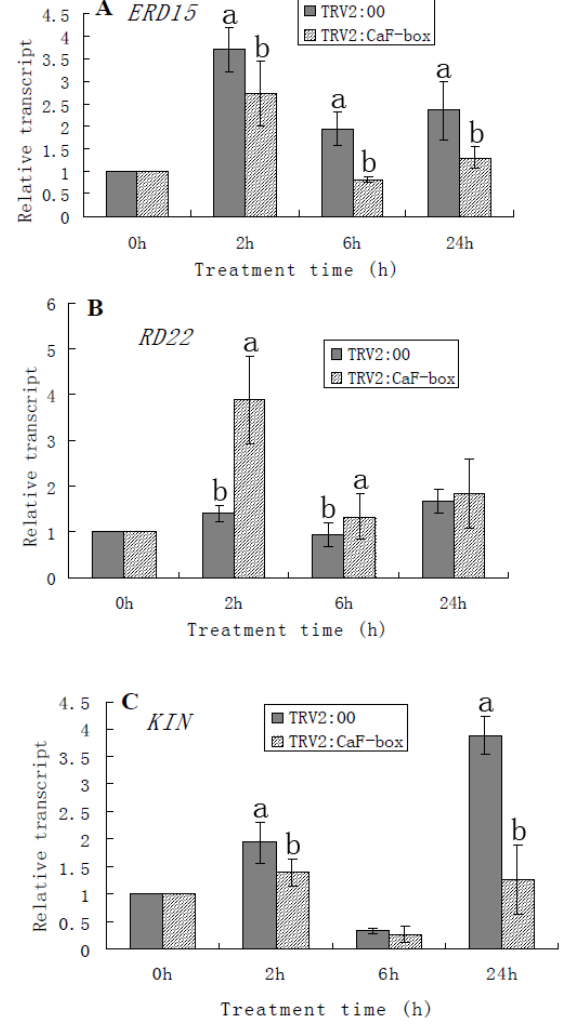
Figure 6. Expression of cold stress-responsive genes in control and CaF-box silenced plants subjected to cold stress. Relative expression levels of cold stress-responsive genes were determined by real time PCR. ( A ) ERD15 gene; ( B ) RD22 gene; ( C ) KIN1 gene. Three biological triplicates were averaged and Bars indicate standard error of the mean. Different letters indicate significant differences ( p <